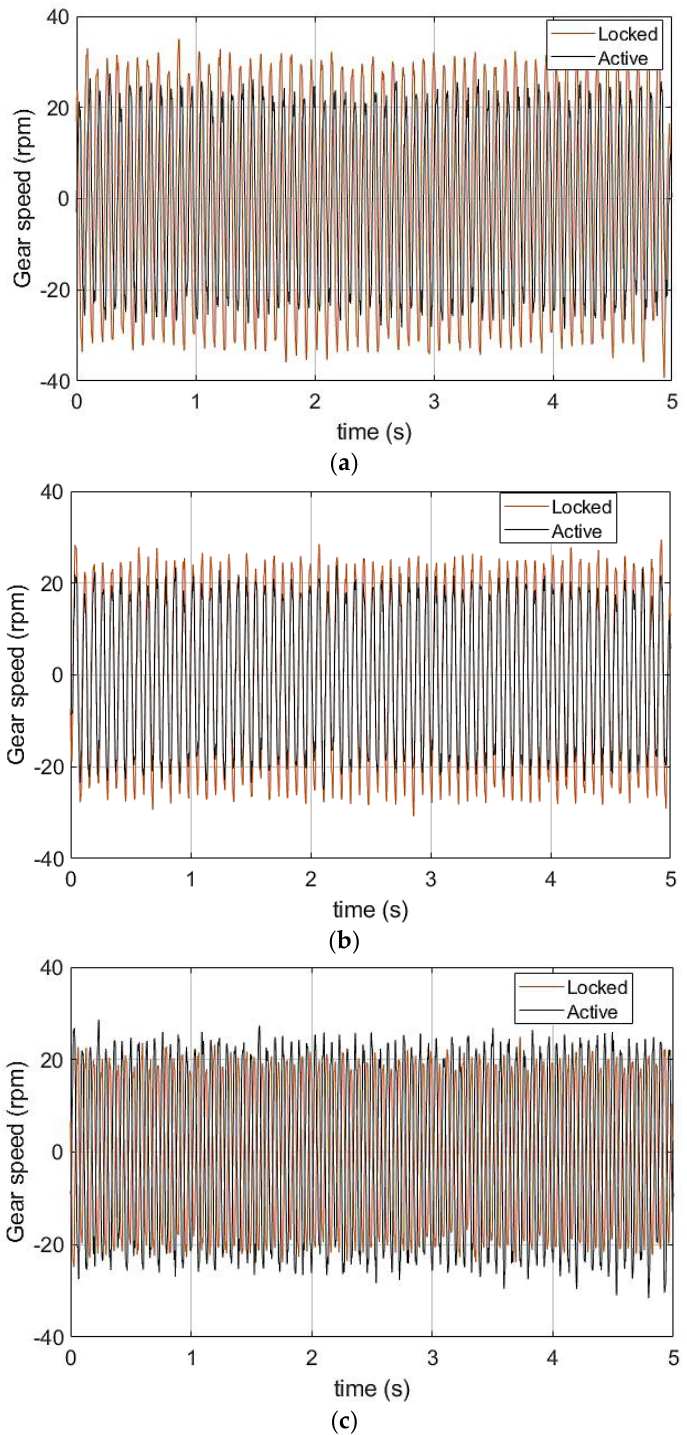
Figure 12. Time histories of the gear vibrations for active and locked NES and mean speed of the pinion; ( a ) 700 rpm; ( b ) 800 rpm; ( c ) 900 rpm.